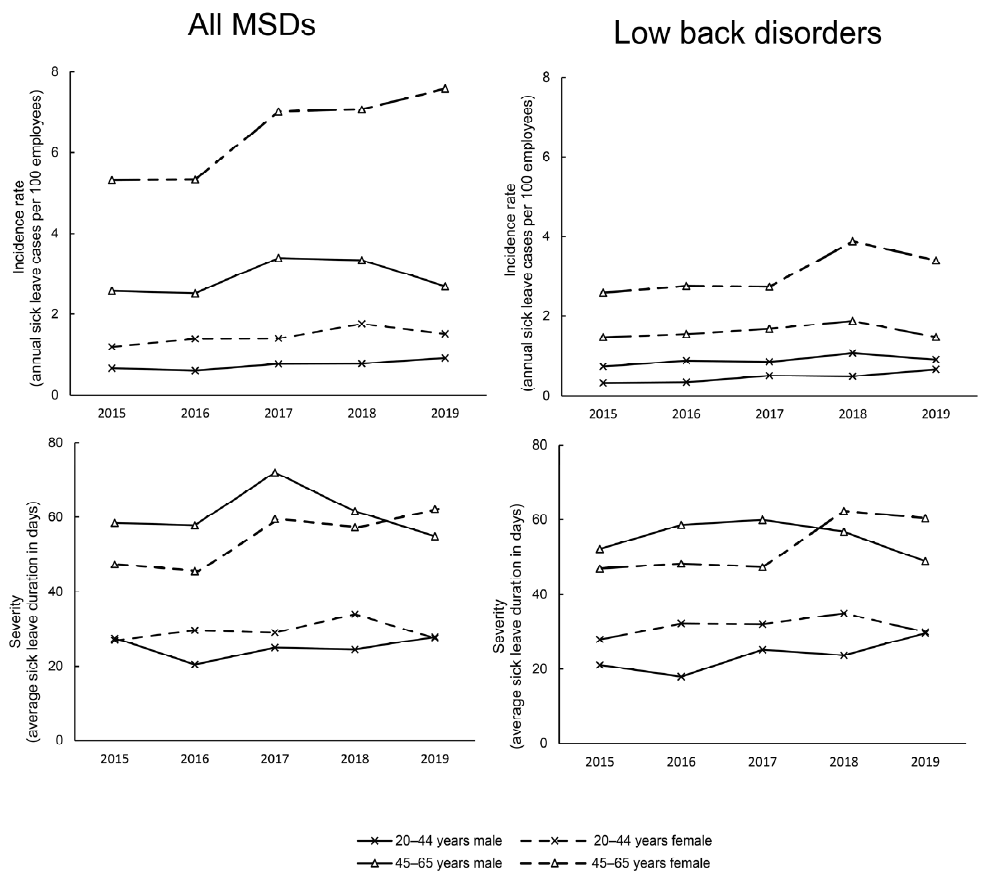
Figure 2. Trends from 2015 to 2019: incidence of musculoskeletal disorder cases and their severity for all body regions combined.